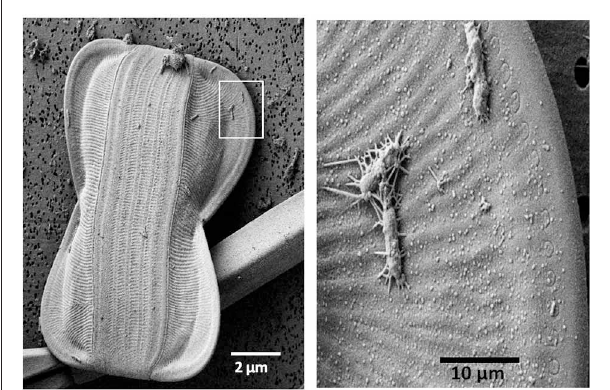
FIGURE 1 | Bacteria can be intimately associated with diatoms. This sea ice Amphiprora diatom cell has bacterial cells attached through an apparently tight association likely via the use extracellular polymeric substances (EPS). SEM micrographs were collected at the UC Riverside Center for Nanoscale Science and Engineering. Samples were filtered, critical point dried to preserve cellular structures, coated with Pt:Pd to prevent charging, and imaged at 2kv on a Zeiss 1540